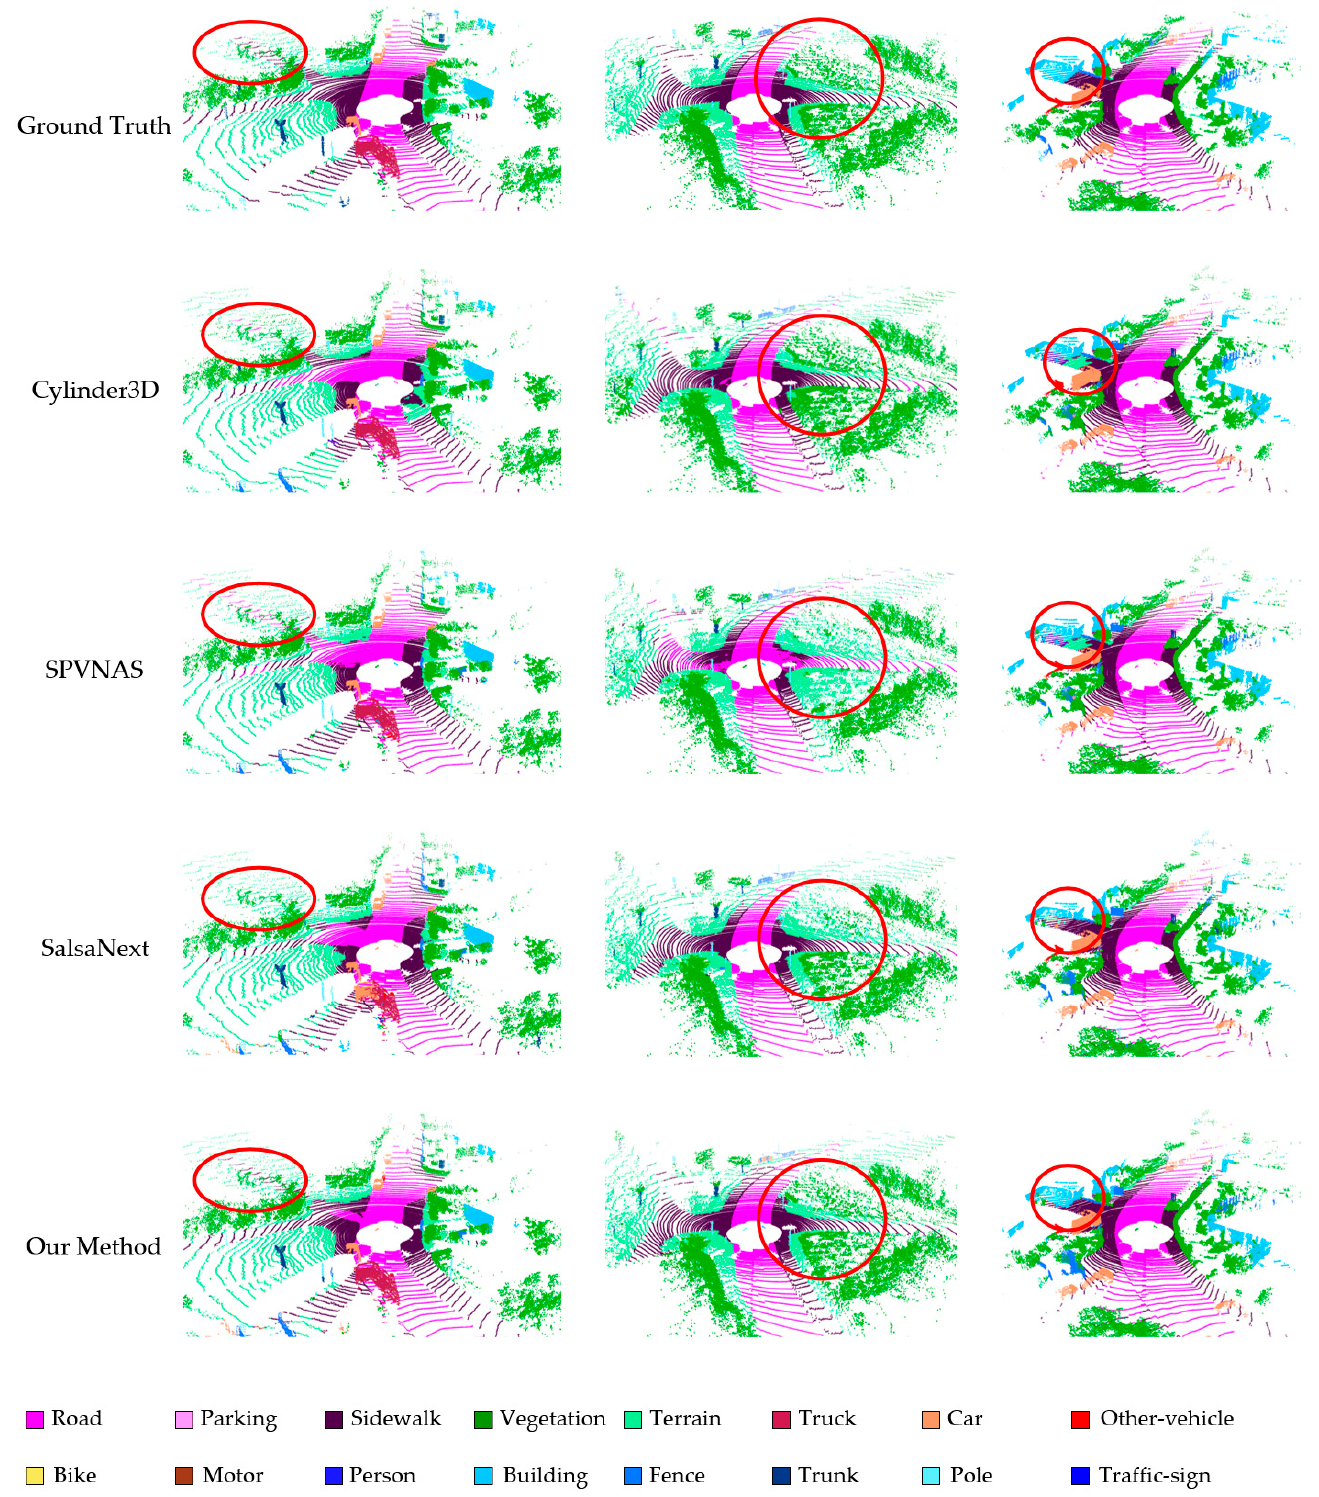
Figure 6. Visual comparison with different state-of-the-art methods on the Semantic KITTI dataset.